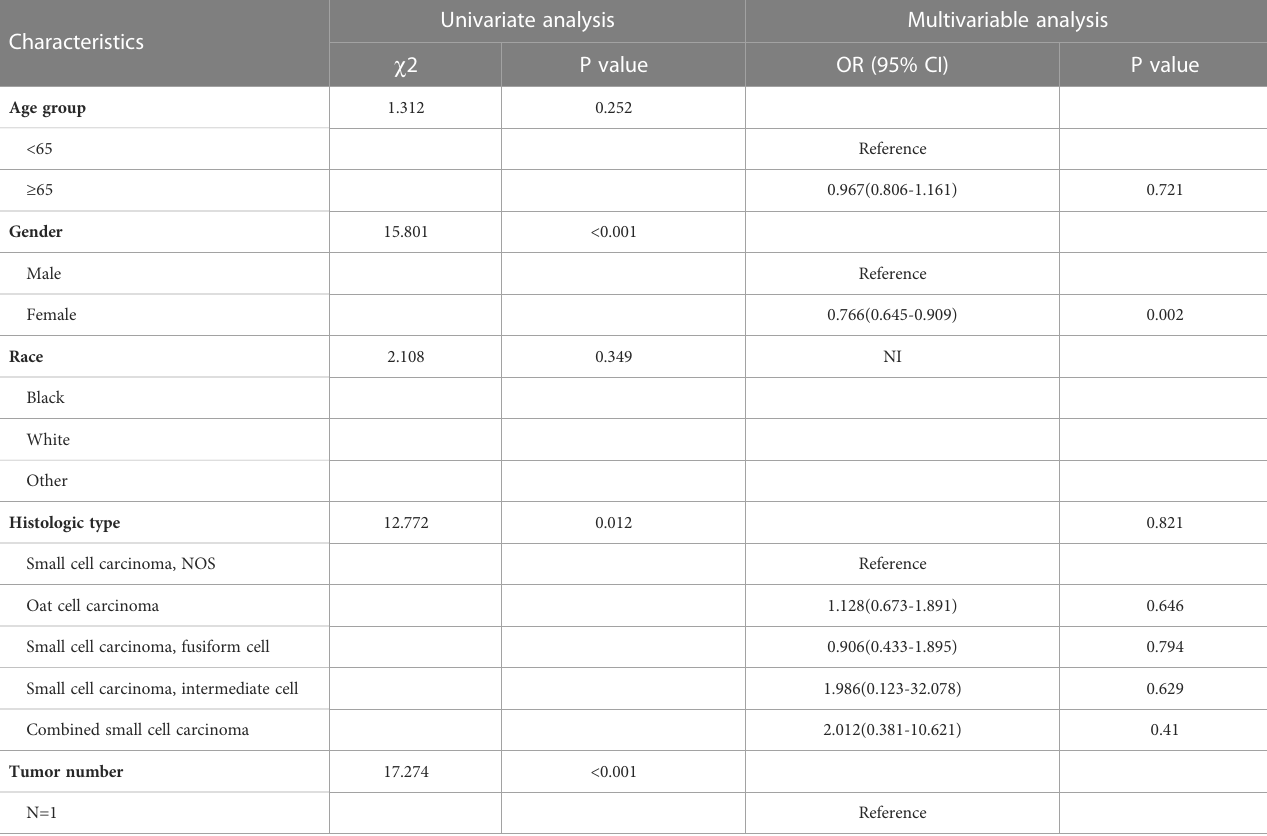
TABLE 2 Univariate and multivariable Logistic regression for developing BM among SCLC patients.